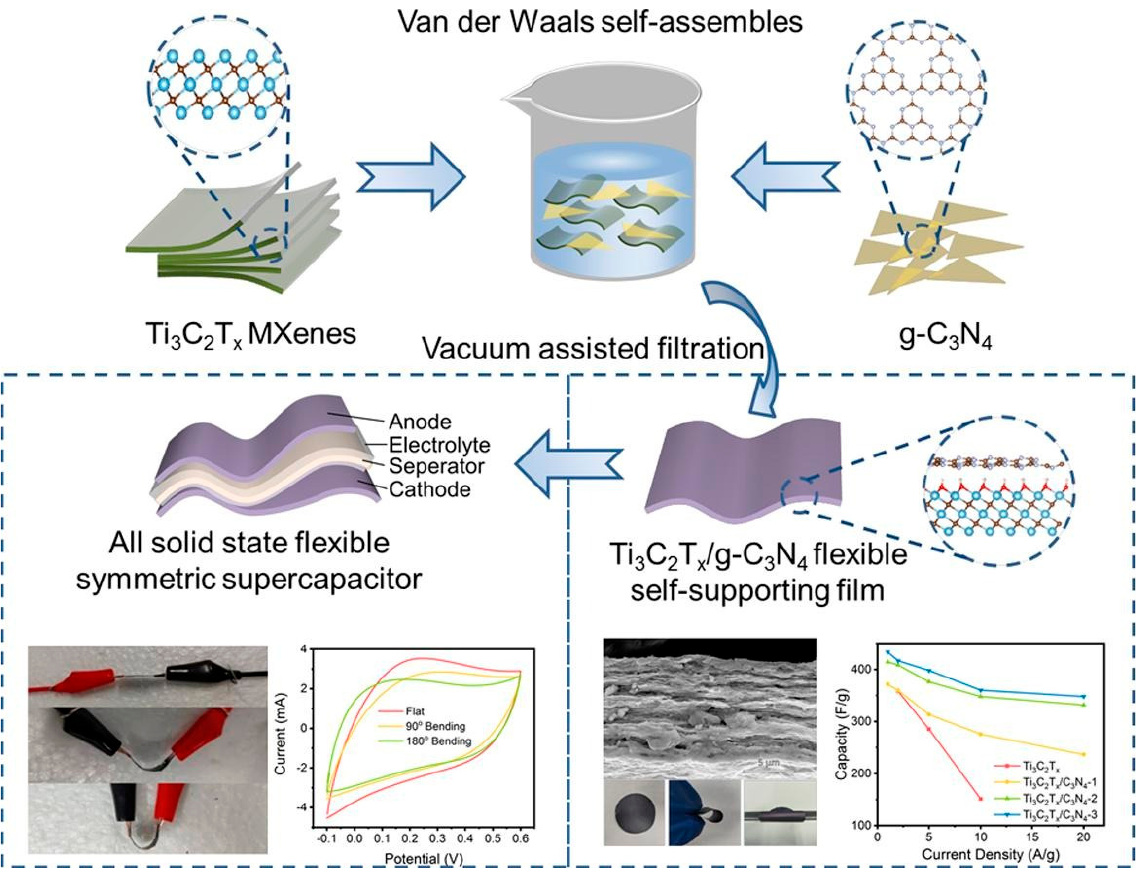
Figure 10. Schematics of fabrication, photos, characterization images, and electrochemical perfor- mance of Ti 3 C 2 Tx/g-C 3 N 4 heterostructure film. Adapted with permission from [122]. © 2022 Elsevier B.V. All rights reserved.